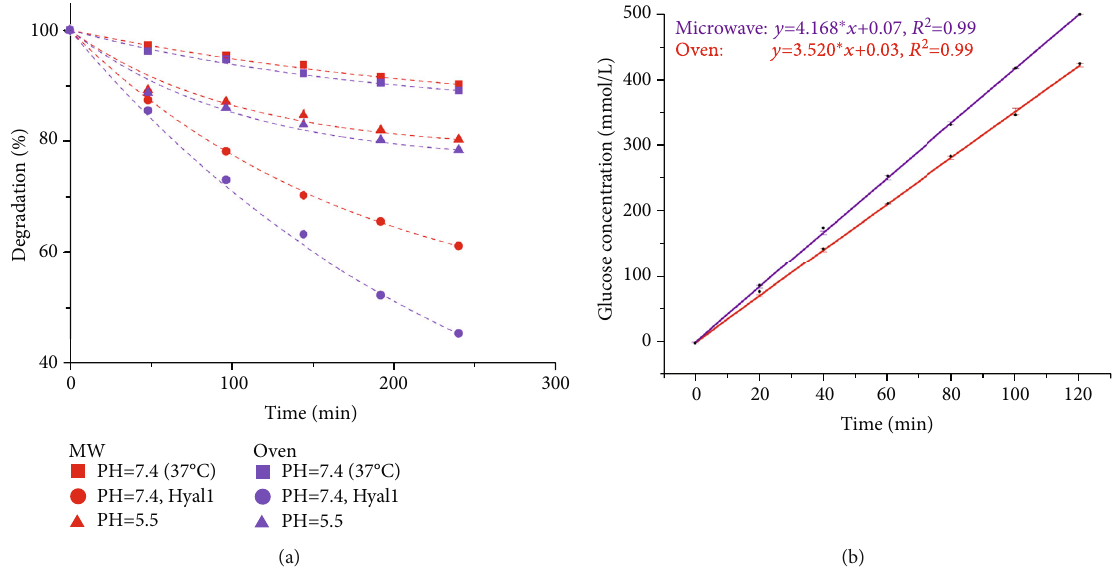
Figure 11: The decomposition rates (a) of two di ff erent methods (microwave-assisted method and traditional oven method) under three di ff erent conditions are shown, respectively, and their glucose iontophoresis results (b) under simulated human